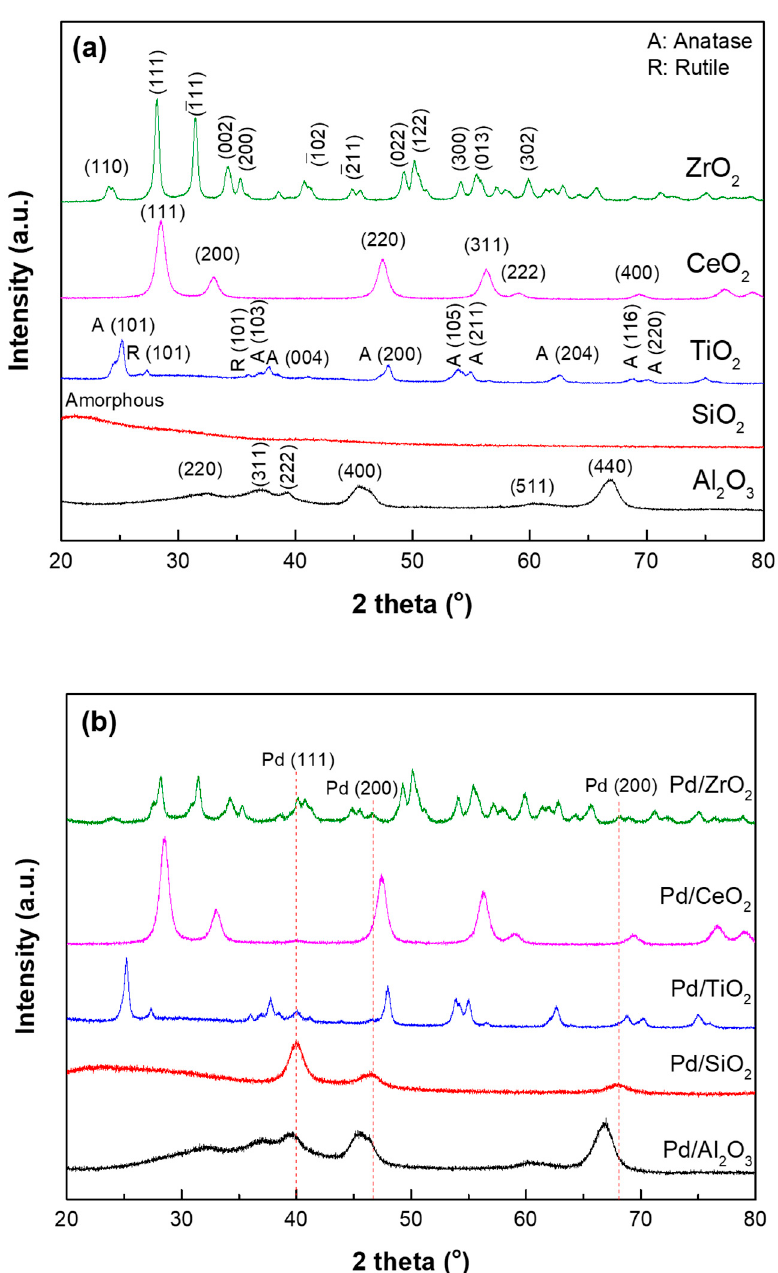
Figure 3. XRD patterns of ( a ) supports and ( b ) supported Pd catalysts.